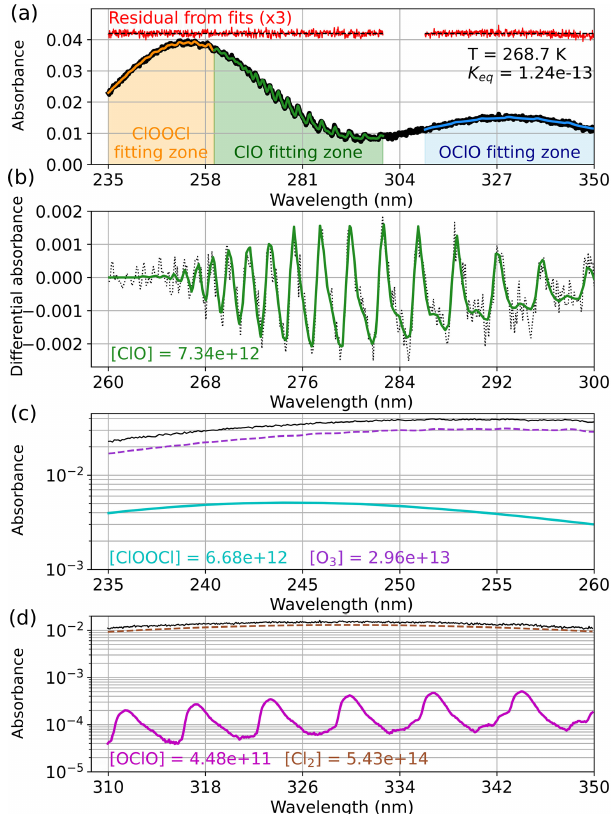
Figure 2. Deconvolution of experimental absorbance spectra to component contributions for an experiment conducted at 268.7K. (a) Experimental spectrum (black) and the wavelength ranges used for quantification of each spectral component (orange: 235–260nm, green: 260–300nm, blue: 310–350nm). The resulting spectral fits for each region are overlaid on the experimental spectrum in col- ored traces; the residuals from the fits are plotted in red, mag- nified by a factor of 3, and offset for clarity. The obtained K eq (cm 3 molecule − 1 ) is indicated in the top right corner. (b) Quan- tification of ClO by the high-pass-filtration method. The differ- ential absorbance spectrum appears as black dots, and the fitted ClO component is depicted in solid green. (c) Quantification of ClOOCl (cyan) and O 3 (purple) with the experimental spectrum shown for reference (black). (d) Quantification of OClO (magenta) and Cl 2 (brown) with the experimental spectrum shown for ref- erence (black). Note that only the primary absorbing species are shown in panels (c) and (d) , but all relevant absorbers are included in the fits. Fitted concentrations (moleculescm − 3 ) are given for var- ious component gases.